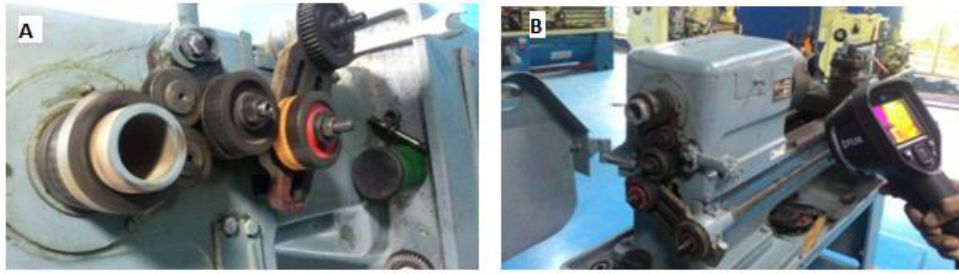
Figure 3. ( A ) Flax fiber-reinforced gear in mesh with metal gear. ( B ) Contactless infra-red temperature (FLIR) temperature measurement.